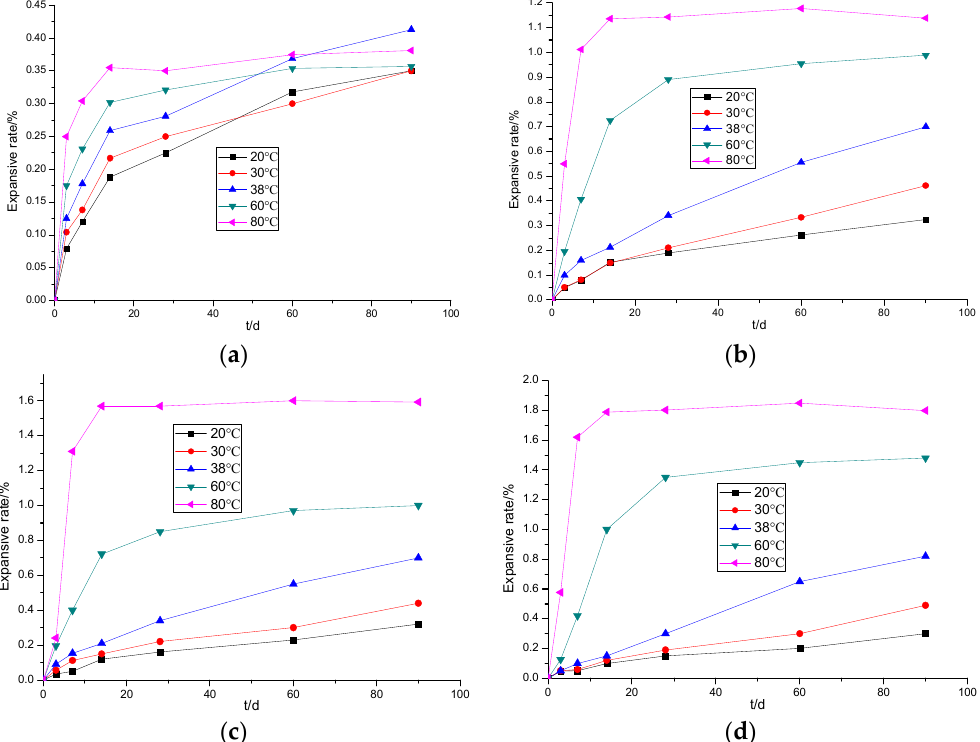
Figure 4. The expansion curves of cement paste mixed with MgO of different activities at different temperatures: ( a ) M65 s; ( b ) M110 s; ( c ) M143 s; ( d ) M190 s.